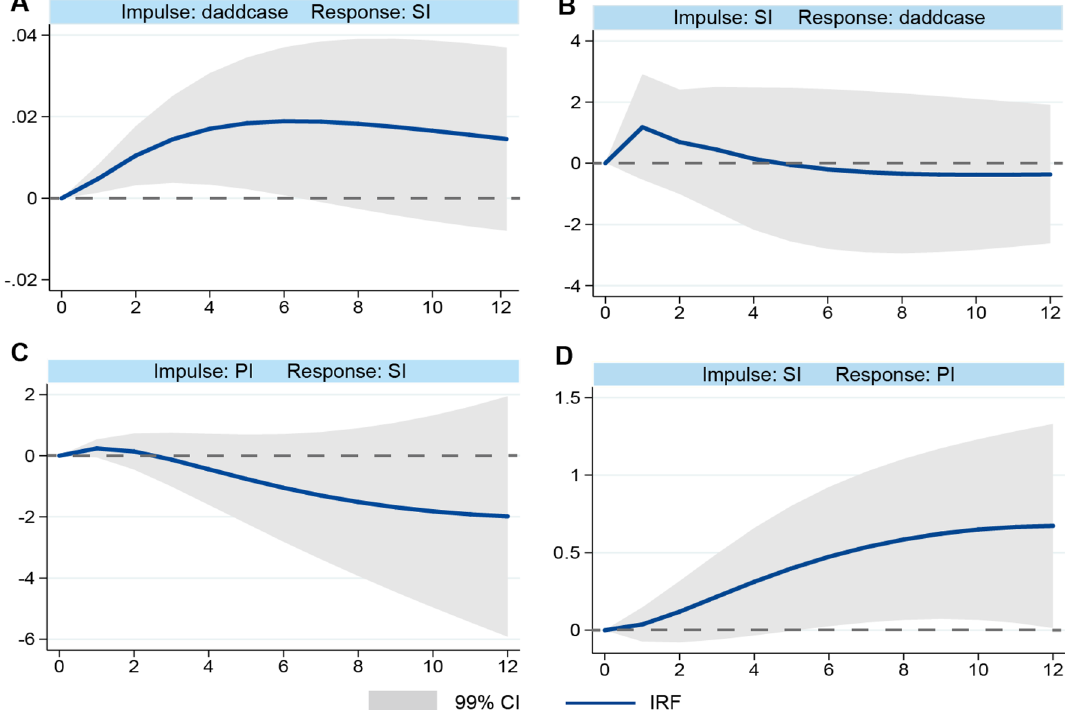
Figure 4. Results of impulse response function (IRF) analysis with silent index (SI), the growth rate of new COVID-19 cases (daddcase), and the policy stringency index (PI). For example, ( A ) indicates the response of SI to daddcase. Impulse response results were obtained by running 500 iterations of the Monte Carlo Simulation; the upper and lower curves represent the 99% CI. The horizontal axis indicates the step numbers of the twelve- period impulse response